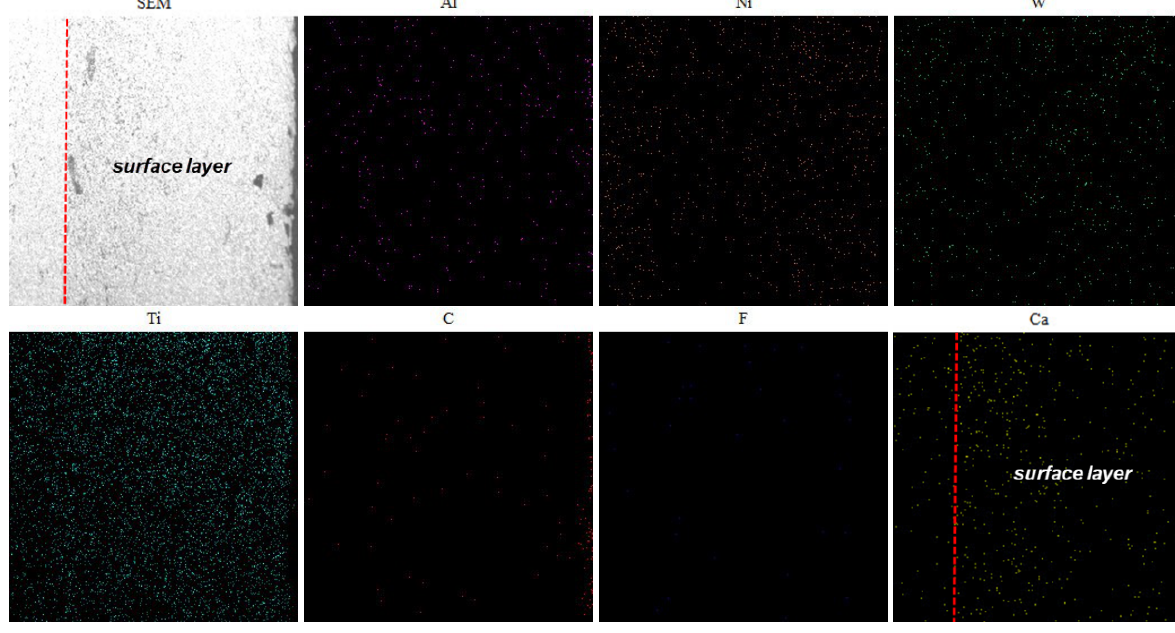
Figure 4: Element distribution of Ni 3 Al-TiC-WC-CaF 2 gradient material (n 1 = 2)